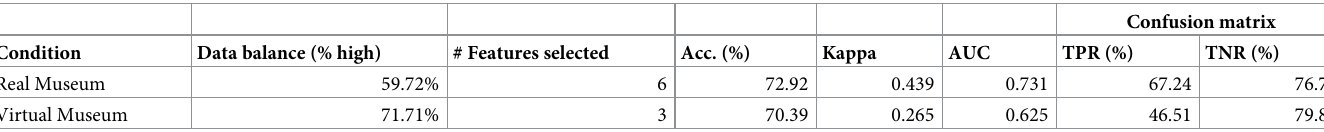
Table 4. Level of arousal recognition in both the real and the virtual museum conditions.